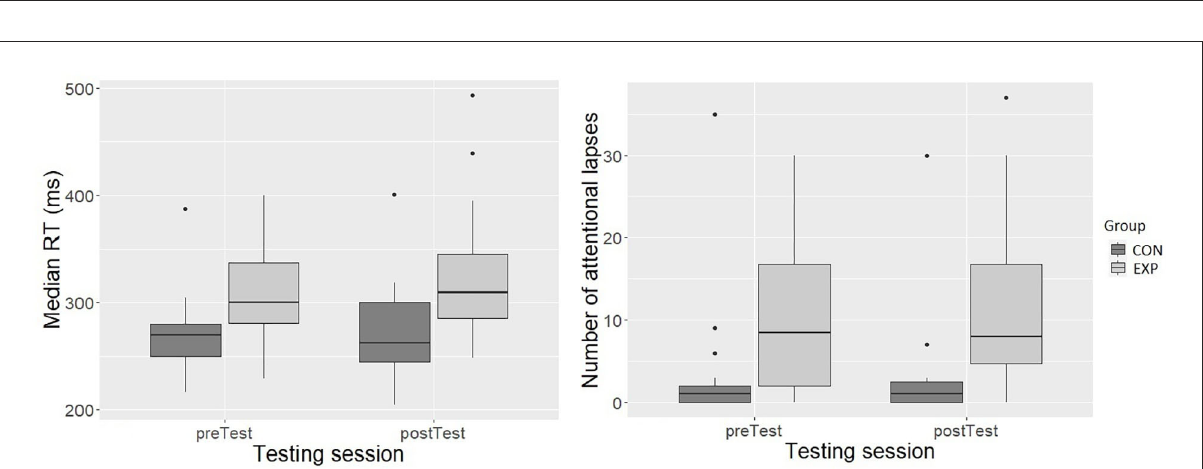
FIGURE4 Median RT (ms) (y-axis; left-side graph) and number of attentional lapses (y-axis; right-side graph) during the two PVT testing sessions (x-axis; both graphs). The box depicts 50 % of all values (IQR). The top 25% and bottom 25% of all values are excluded from the box. The top and bottom of the whiskers are the minimum and maximum, excluding outliers (defined 1.5 x IQR). The horizontal line inside the box represents the median value.